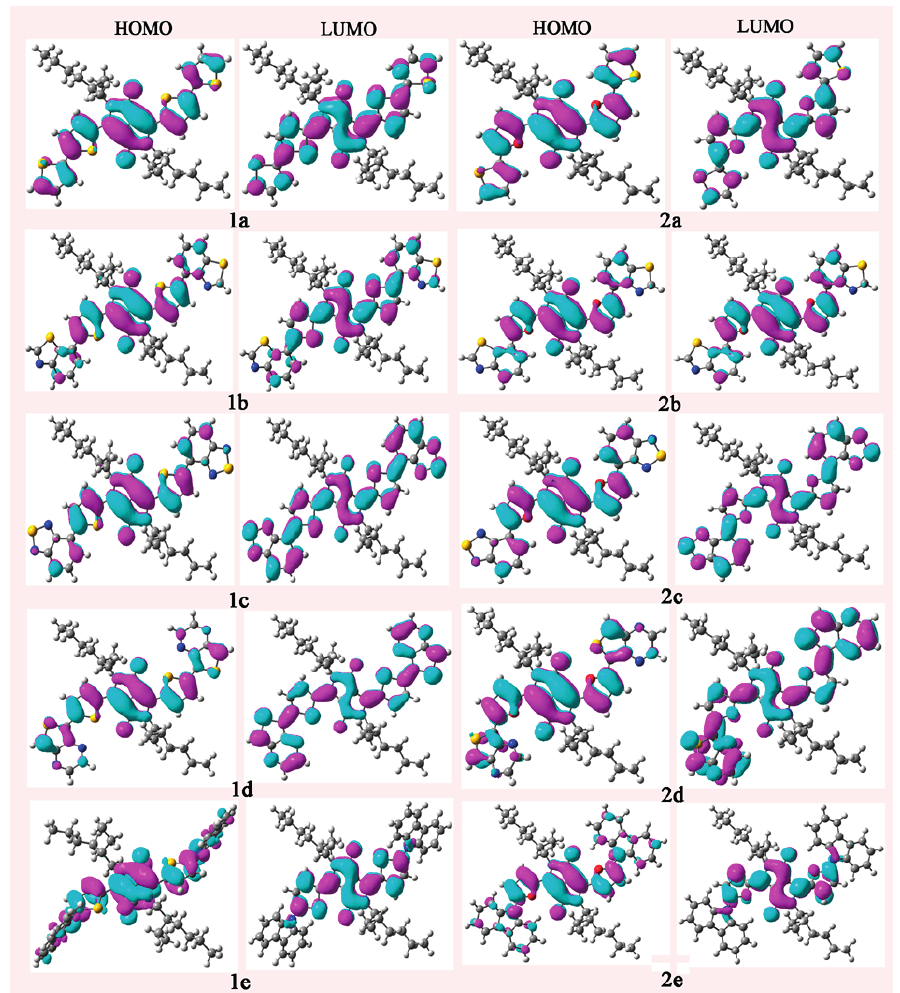
Figure 1. The electronic density contours of the frontier orbitals for the compounds under investigation at the B3LYP/6-31G(d,p) level. Table 1. The HOMOs and LUMOs contributions of individual fragments (in%) to the FMOs of the investigated molecules at the B3LYP/6-31G(d,p) level. HOMOs Species